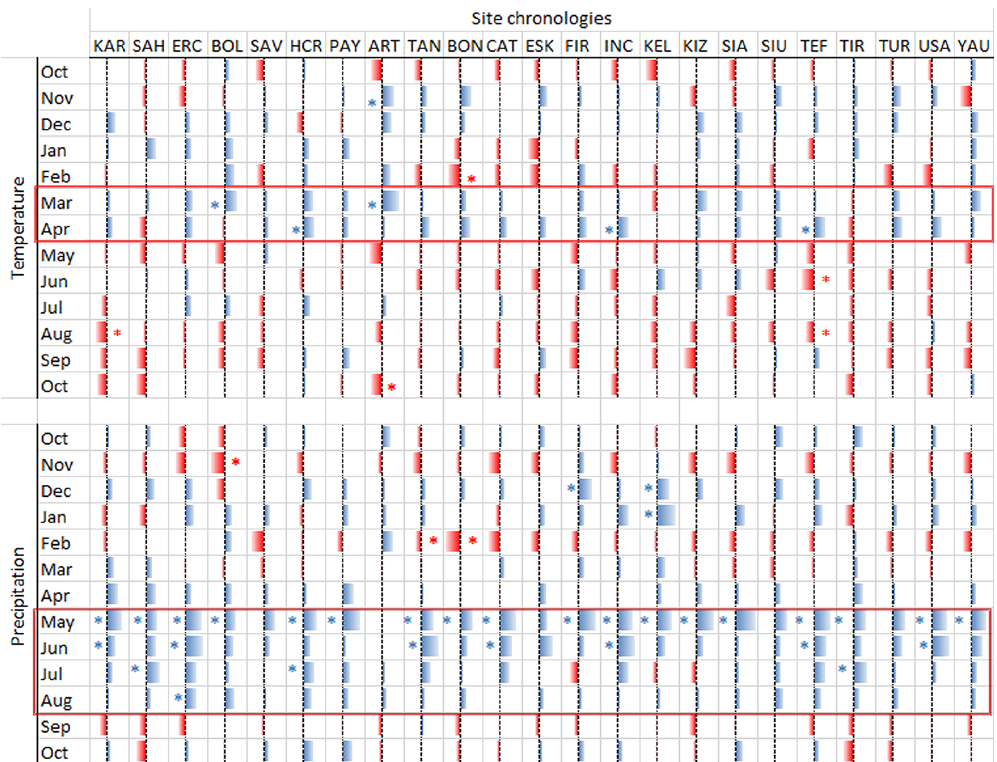
Figure 2. Summary of response function results of 23 chronologies. Red color represents negative effects of climate variability on tree ring width; blue color represents positive effects of climate variability on tree ring width; ∗ indicates statistically significant response function coefficient ( p <0.05). Each response function includes 13 weights for average monthly temperatures and 13 monthly precipitations from October of the prior year to October of the current year.